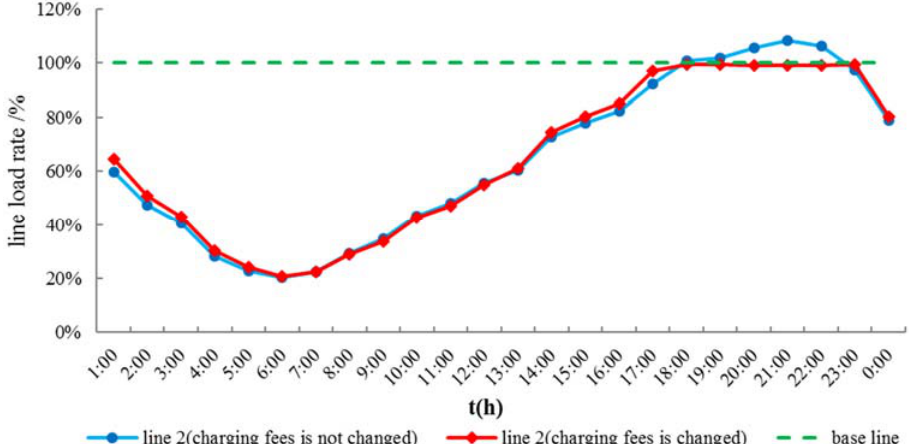
Figure A1. Line load rate of line 2 before and after adjustment for charging fees.